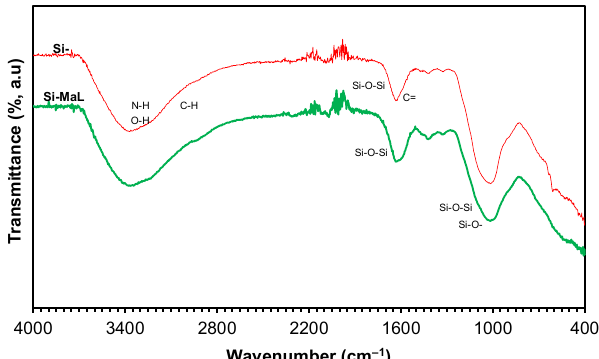
Fig. 1. FT-IR spectra of the Si-MaL dan Si-Kit adsorbents